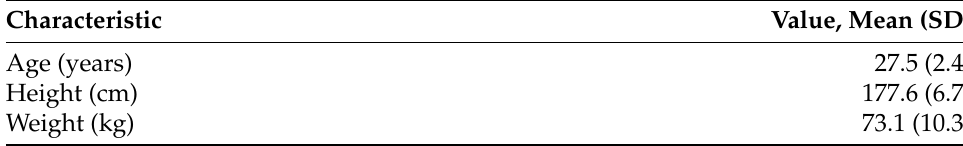
Table 1. Participants’ demographic characteristics in the WESAD dataset (N =